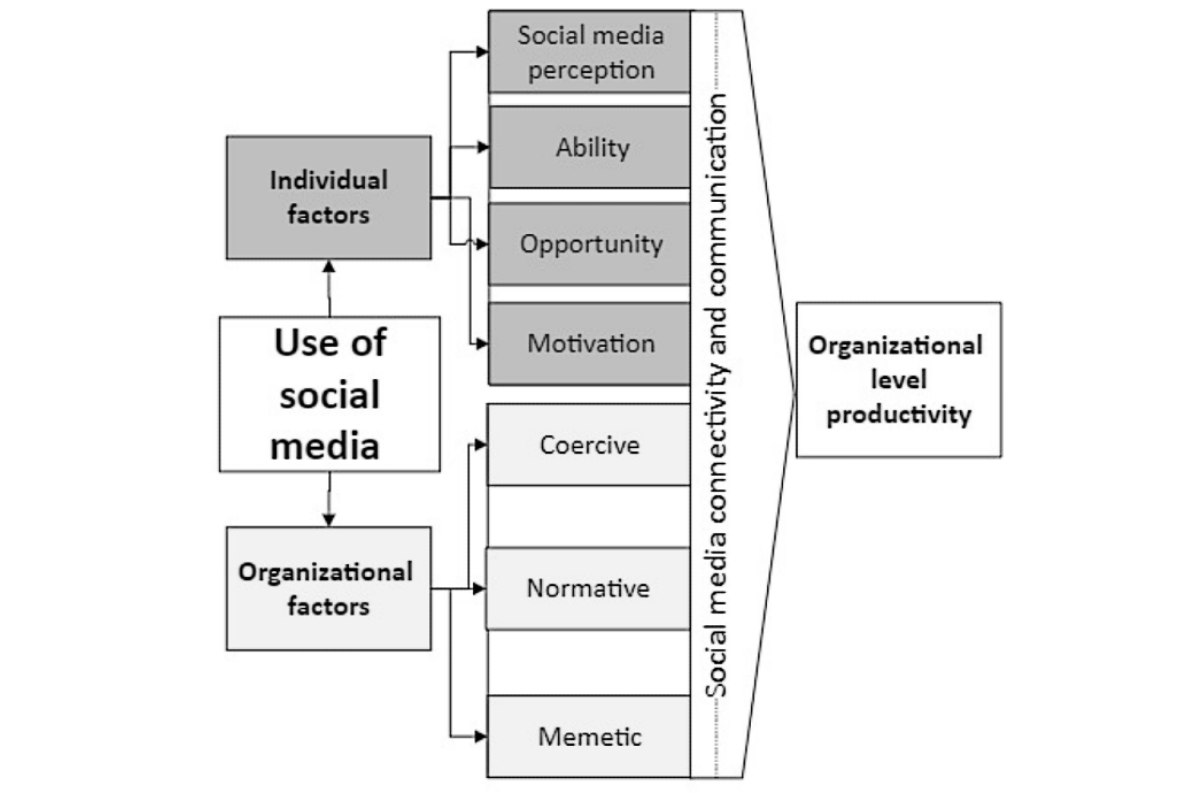
Figure 1. Theoretical framework based on institutional and ability, motivation, and opportunity